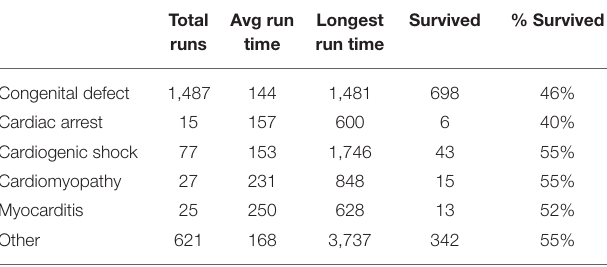
TABLE 1 | Neonatal cardiac runs by diagnosis in the last five years (2014–2019), ELSO registry report January 2019 (1).